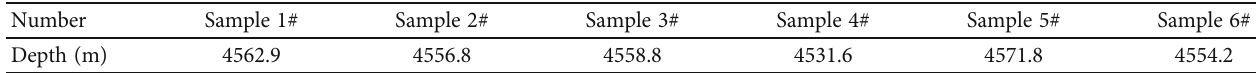
Figure 4: CT scan of open-hole. (a) Sample 1#. (b) Sample 2#. (c) Sample 3#. (d) Sample 4#. (e) Sample 5#. (f) Sample 6#. Table 3: Depth of experimental